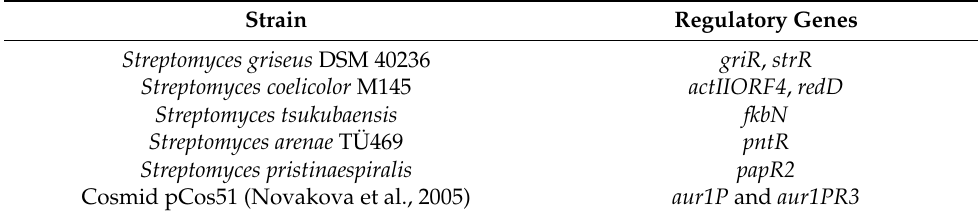
Table 1. Sources for the amplification of regulatory